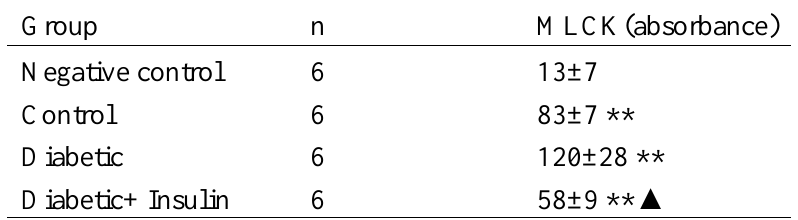
Table 2. The effects of streptozotocin-diabetes and insulin treatment on the integral absorbance in gomenulus of kidney( mean ±